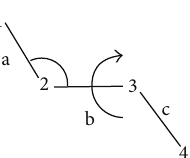
Figure 7: Schematic diagram for relations between Cartesian and internal coordinates for four